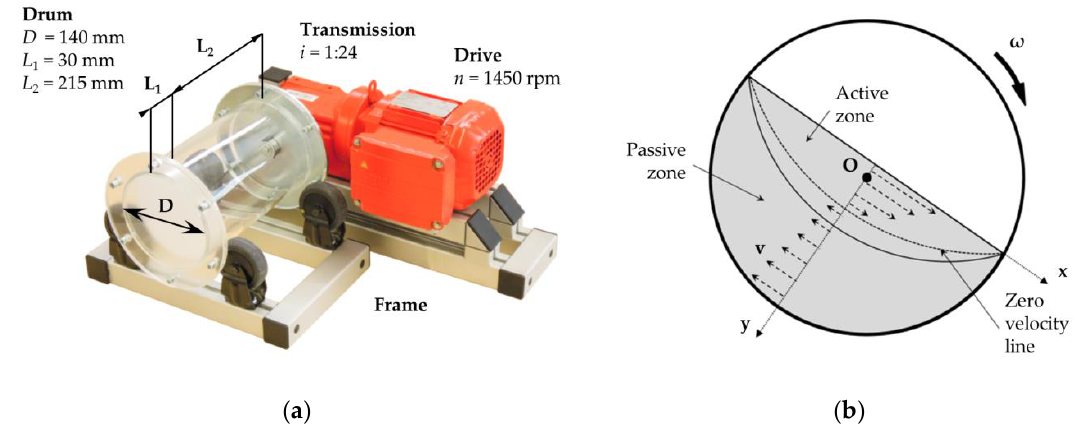
Figure 3. Rotary drum: ( a ) experimental rotary drum assembly; ( b ) schematic representation of active and passive mixing zones.